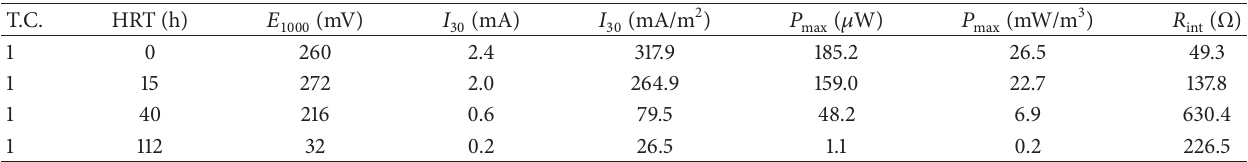
Table 2: MFC feeding with SW1 wastewater. Polarization curves overview of treatment cycle 1. 𝐸 1000 represents the cell voltage at external resistance of 1000 Ω , 𝐼 30 represents the current intensity at external resistance of 30 Ω (i.e., potentiometer range).